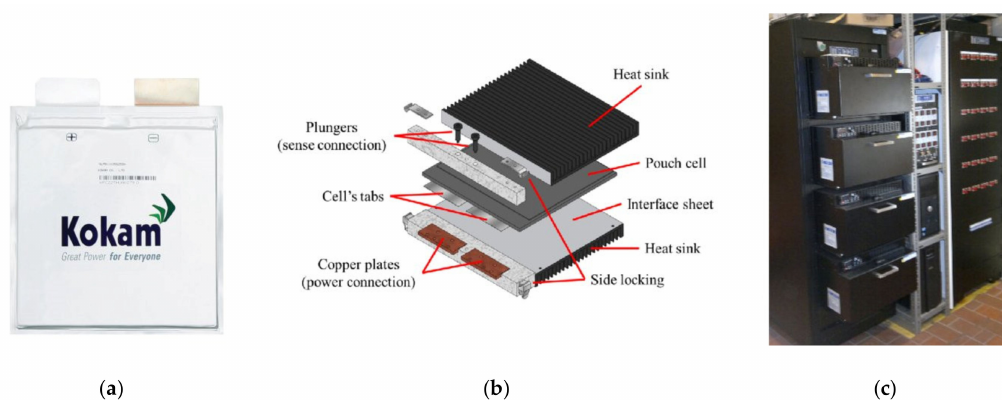
Figure 9. Test setup: ( a ) Kokam 53 Ah SLPB pouch cell; ( b ) 3-D representation of one of the cells and its holder; ( c ) from right to left, Maccor 4000 Series automated battery tester, FRA, and thermal chambers